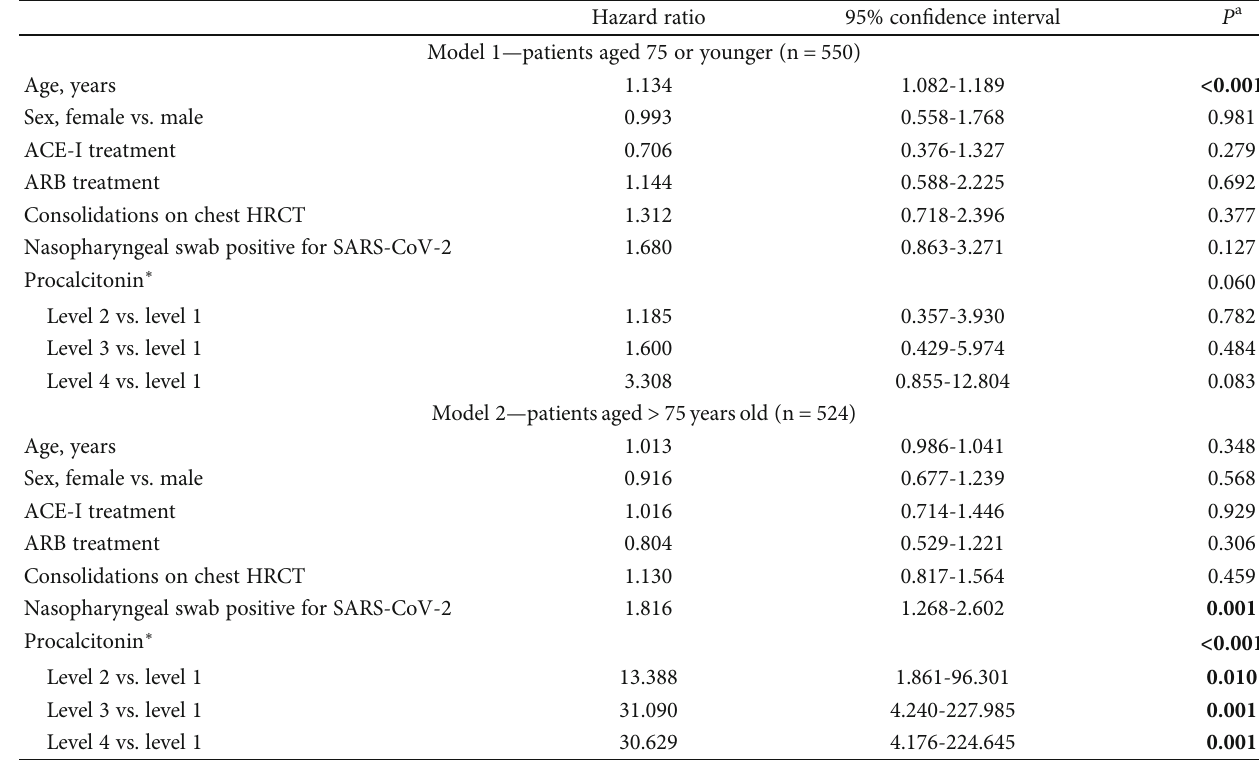
Table 5: Multivariate Cox regression model, testing variables associated with hospital mortality.